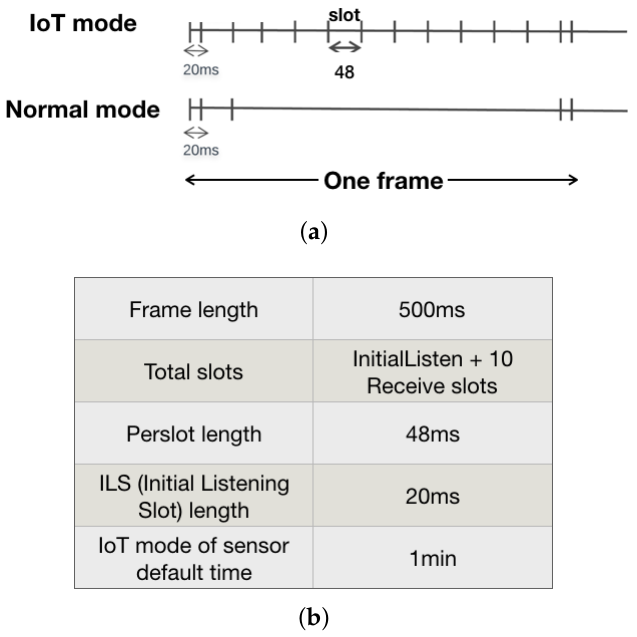
Figure 5. Sensor communication frames. ( a ) Frame structure for sensors in the two activity modes. ( b ) Frame and slot length